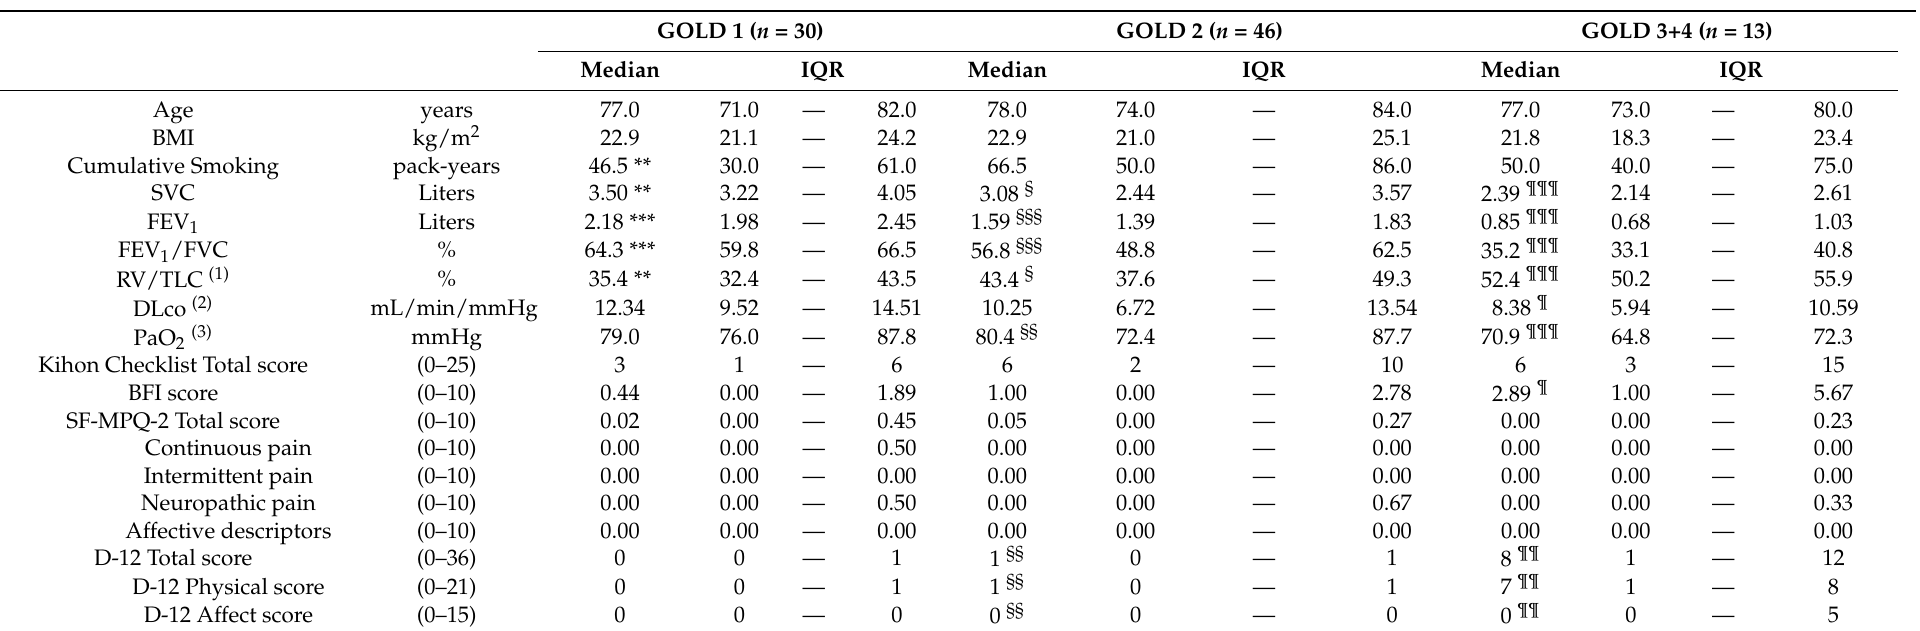
Table 3. Comparison of clinical indices and scores obtained from fatigue, pain and